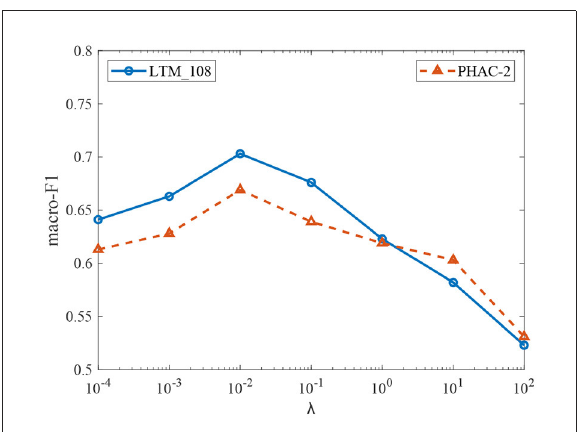
FIGURE9 The performance of proposed model in terms of λ